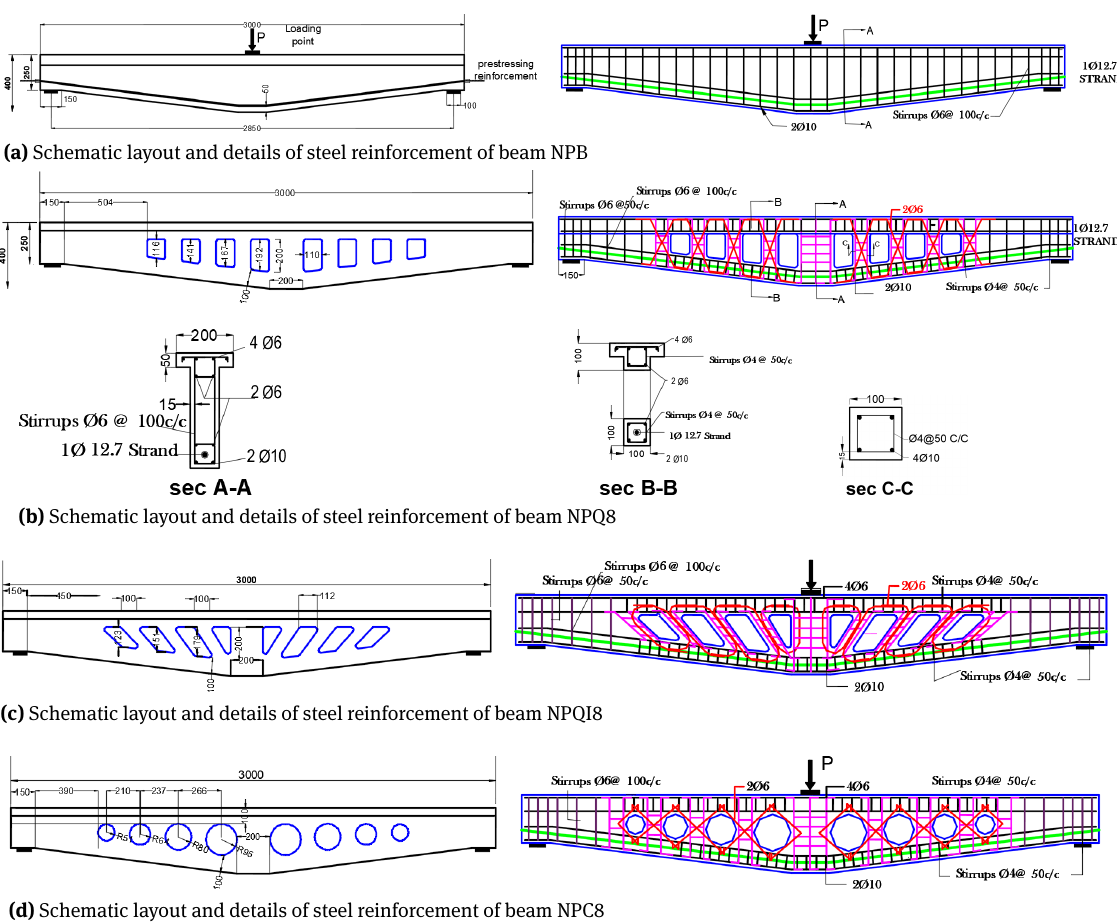
Figure 1: Schematic layout and details of steel reinforcement for all specimens. (Note: All dimensions in